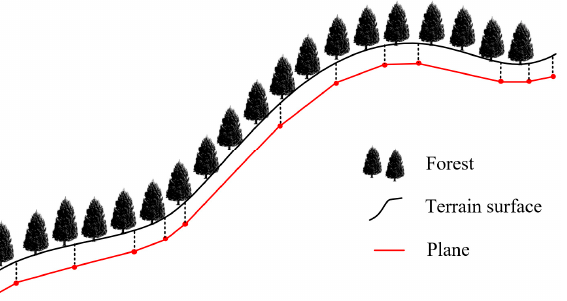
Figure 5. An illustration of irregular terrain characterized by multi-scale planes. The local terrain with larger slope variations is represented by the plane with smaller size.